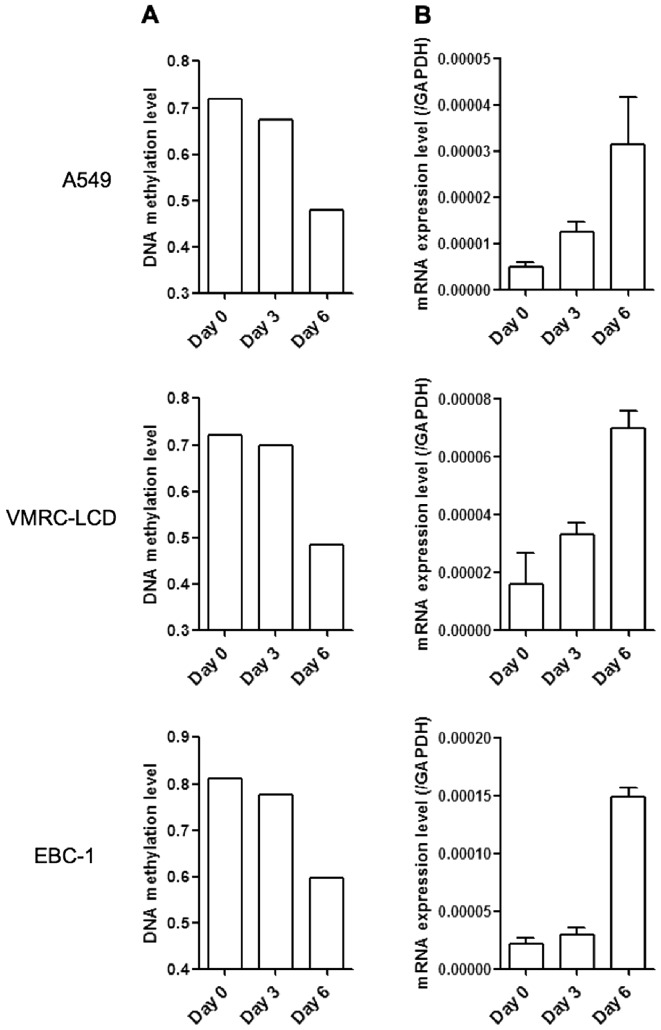
DNA methylation and mRNA expression levels after 5-aza-2′-deoxycytidine (5-aza-dC) treatment. (A) DNA methylation (average values) and (B) mRNA expression levels for PTPRH were determined by the Infinium assay and qRT-PCR analysis, respectively. The error bars represent the standard deviation for triplicate qRT-PCR analyses. DNA methylation and mRNA expression levels on days 3 and 6 were compared with those of untreated cells. After 5-aza-dC treatment, reduction of DNA methylation levels and restoration of the PTPRH mRNA expression levels were observed in both of the cell lines used. qRT-PCR, quantitative real-time reverse transcription-polymerase chain reaction.